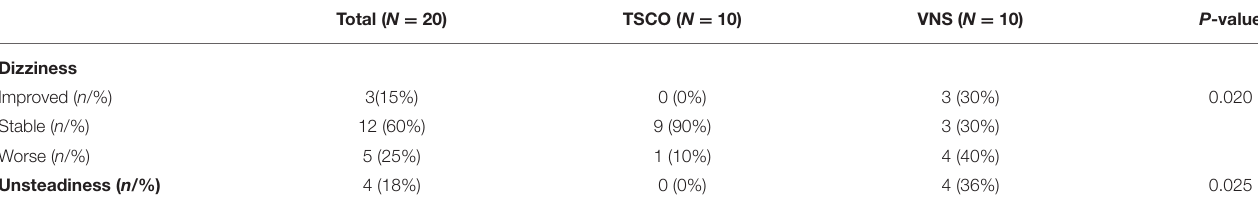
TABLE 5 | Comparison of postoperative symptoms between the two groups. Total ( N = 20) TSCO ( N = 10) VNS ( N = 10) P -value Dizziness Improved ( n